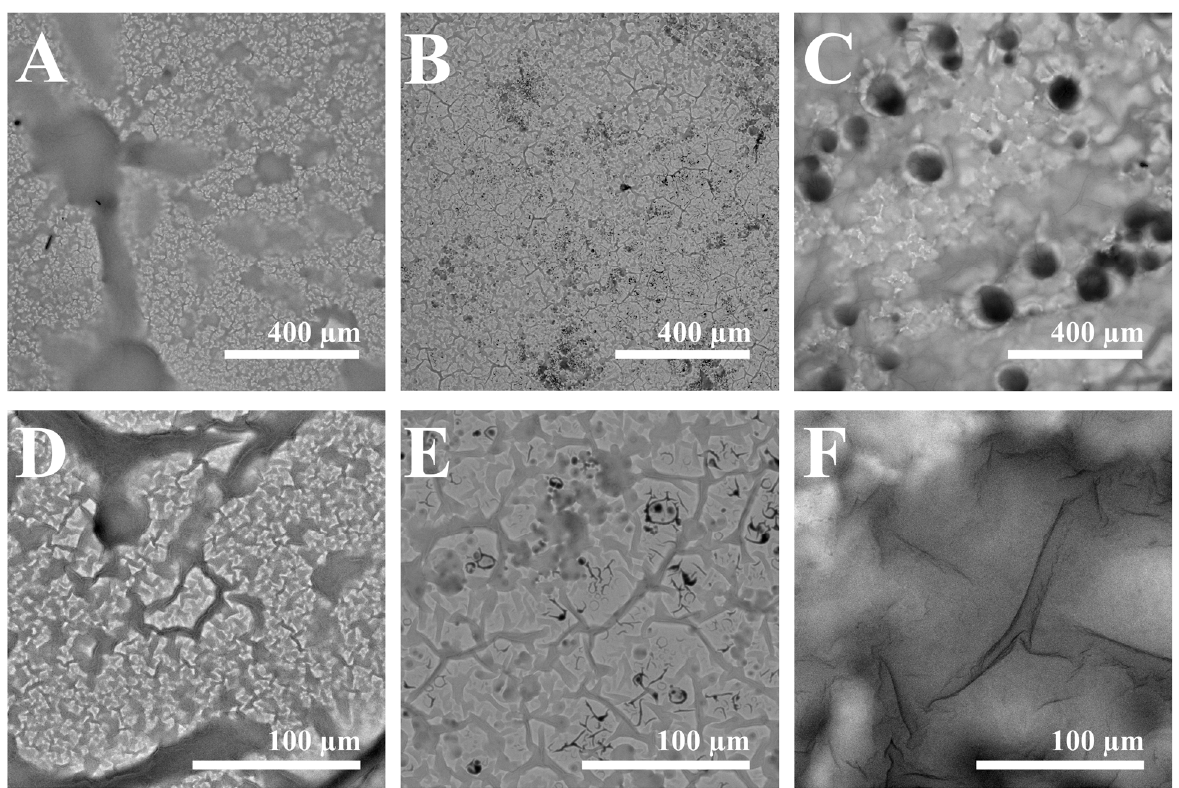
Figure 4. SEM images of ( A , D )—(Ppy-PMB) Lac , ( B , E )—(Ppy-PMB) Suc , ( C , F )—(Ppy-PMB) Hep . Magnification for ( A – C ) was × 200 and for ( D – F ) was × 1000. Imaged area for ( A – C ) is of 1125 μ m × 1125 μ m and for ( D – F ) is 225 μ m × 225 μ m.